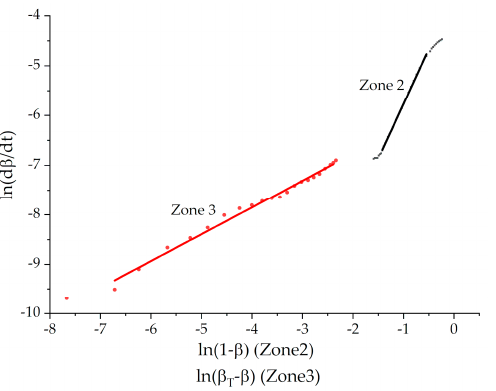
Figure 6. The process of curing in coordinates of the Equations (7) and (8) in logarithmic form for determining the reaction order (n) and rate constant (k) by linear fit for formulation 1 at isotherm of 150 ° C. Table 6. The reaction order and rate constants of zone 2 for formulations 1–3. Formulation Number